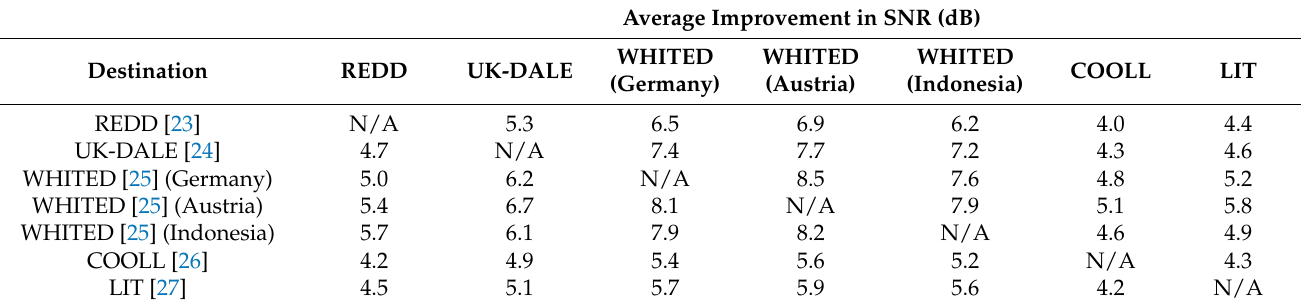
Table 4. Average improvement in SNR with standalone CEEMD.